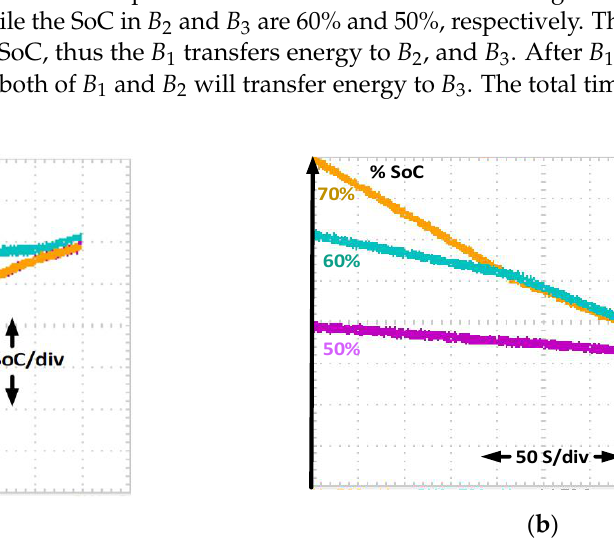
Figure 8. SOC balancing mode for ( a ) charging; ( b ) discharging conditions.